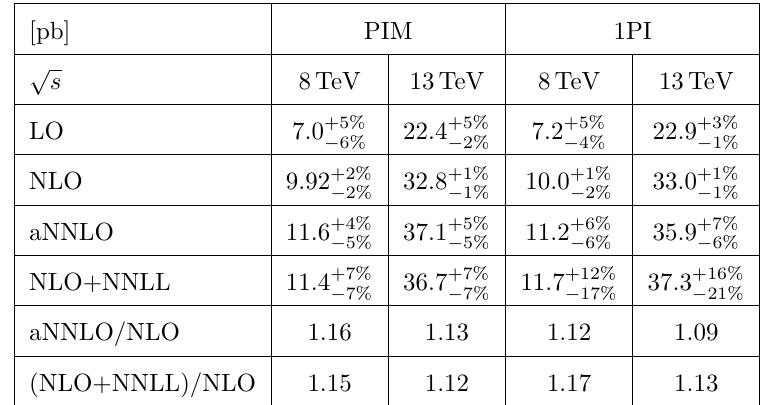
Table 2 . Total cross sections for tW (cid:0) production in PIM and 1PI schemes. The NLO cross sections are calculated using DS scheme.